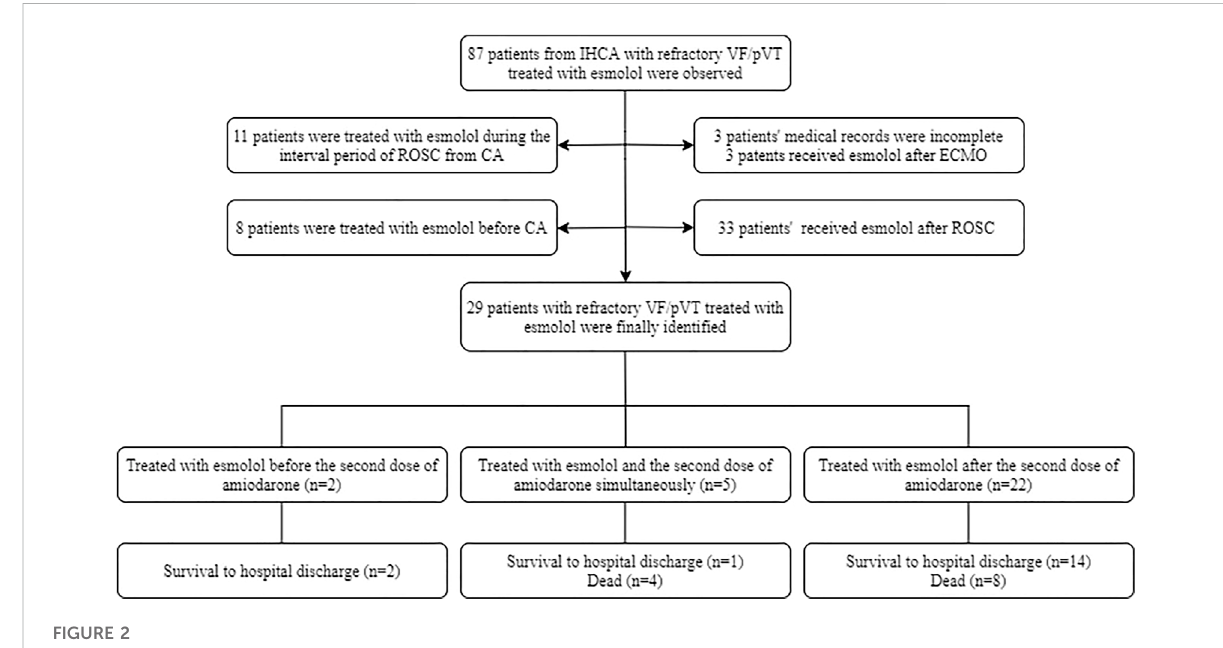
FIGURE 2 Patient fl owchart and brief